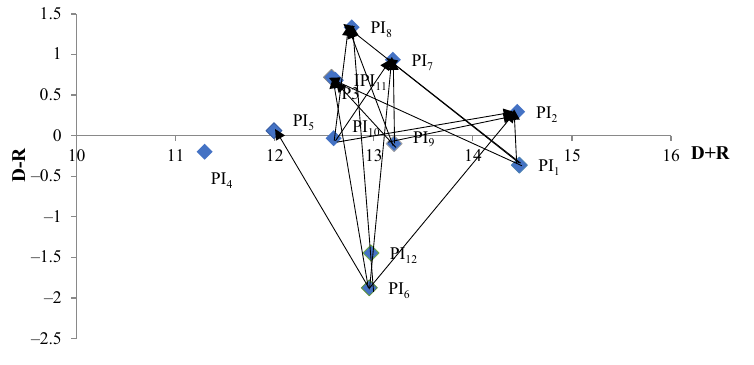
Figure 2. Cause and effect diagram of resilient PSC